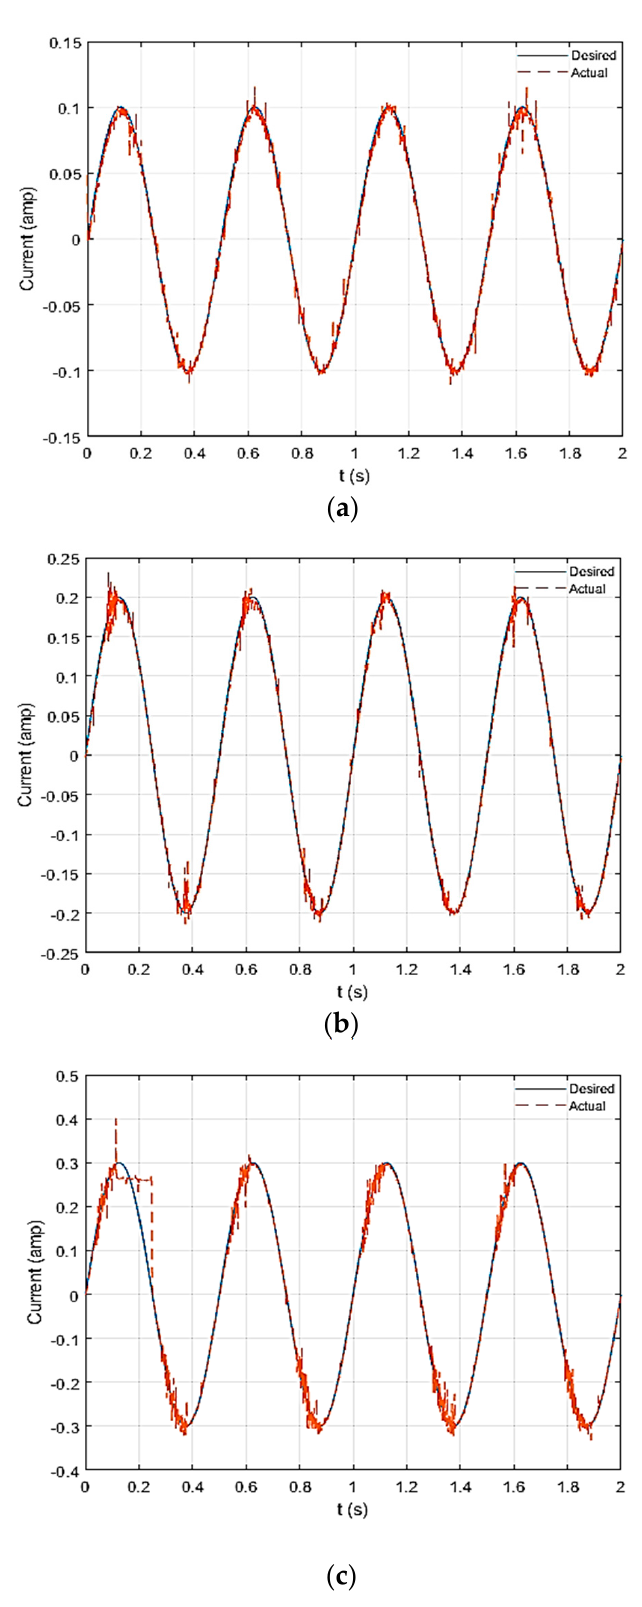
Figure 8. Current vs. time when amplitudes are considered as ( a ) 0.1amp ( b ) 0.2 amp and ( c ) 0.3 amp.